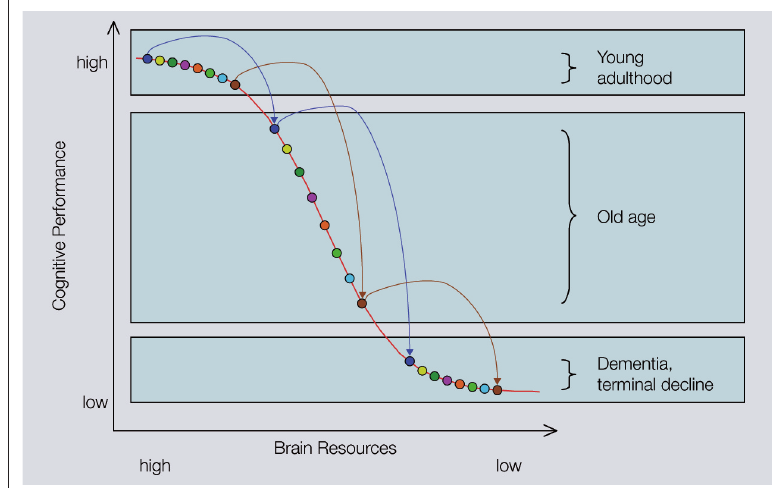
Figure 1 | The resource modulation hypothesis posits that losses in chemical and structural brain resources associated with normal aging modulate the effects of common genetic variation on cognitive performance. As normal aging moves individuals’ resources from the top to the middle portion of the resource function, constant amounts of genetic variation are translated into increasingly larger performance differences. With depleted resources, genetic effects are expected to dwindle again. The colored circles represent eight individuals with different combinations of genetic polymorphisms as they move from early adulthood over old age to dementia or terminal